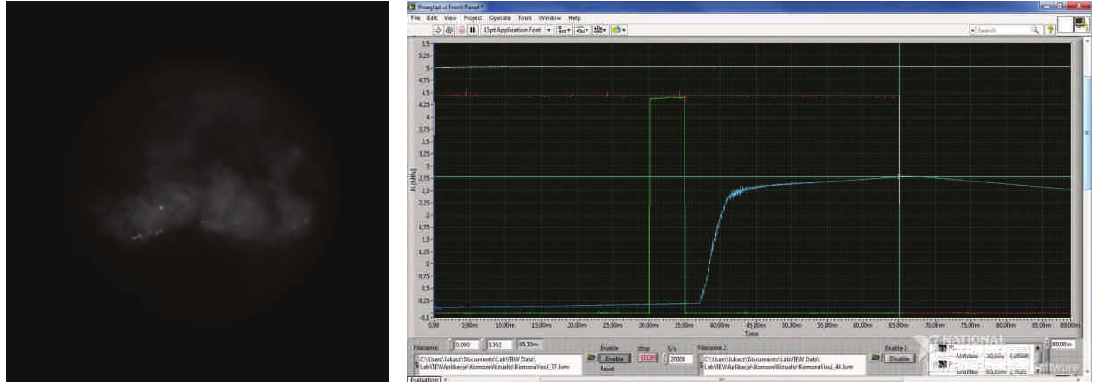
Fig. 4c. Photo of combustion progress and pressure course with marked pressure value 30.1ms after combustion initiation. Combustion initiation – 35 ms after opening of